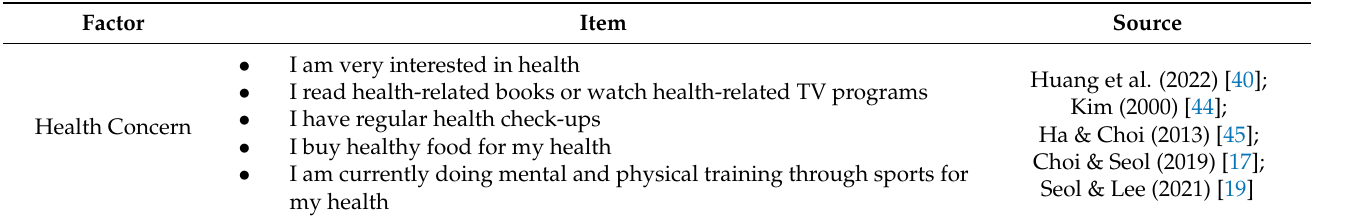
Table 2. Health concern of active senior campers.